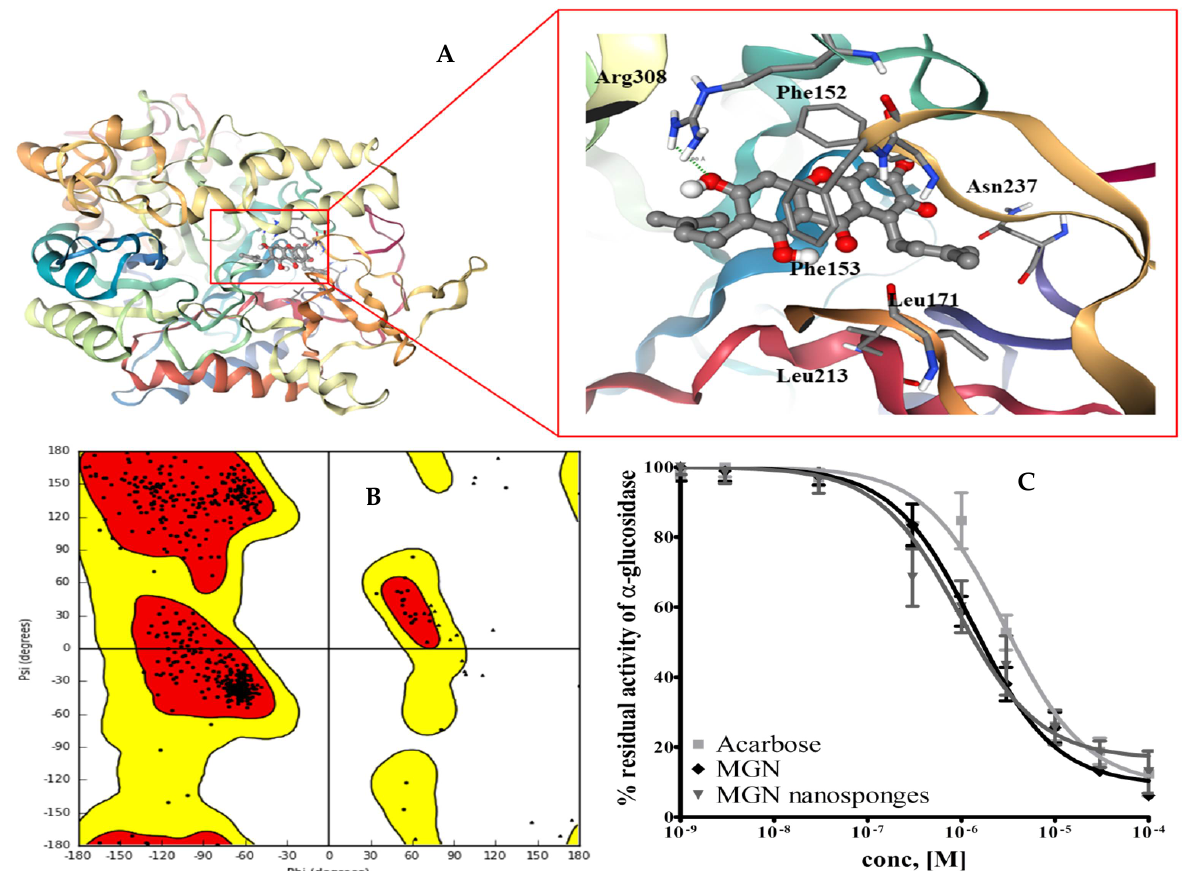
Figure 4. The simulated binding mode of the MGN in the binding site of yeast α -glucosidase. The ligand is presented in a ball and stick model with the hydrogen bond represented with dashed lines. The graphic was rendered using NGL viewer ( A ). The Ramachandran plot of the developed model. The core and outer contours present the allowed and the generously allowed regions ( B ). Inhibition studies of MGN nanosponges against α‐ glucosidase with IC 50 values of 1.353 μ M (MGN), 0.9352 μ M (MGN nanosponges), and 2.909 μ M (acarbose) ( C ).